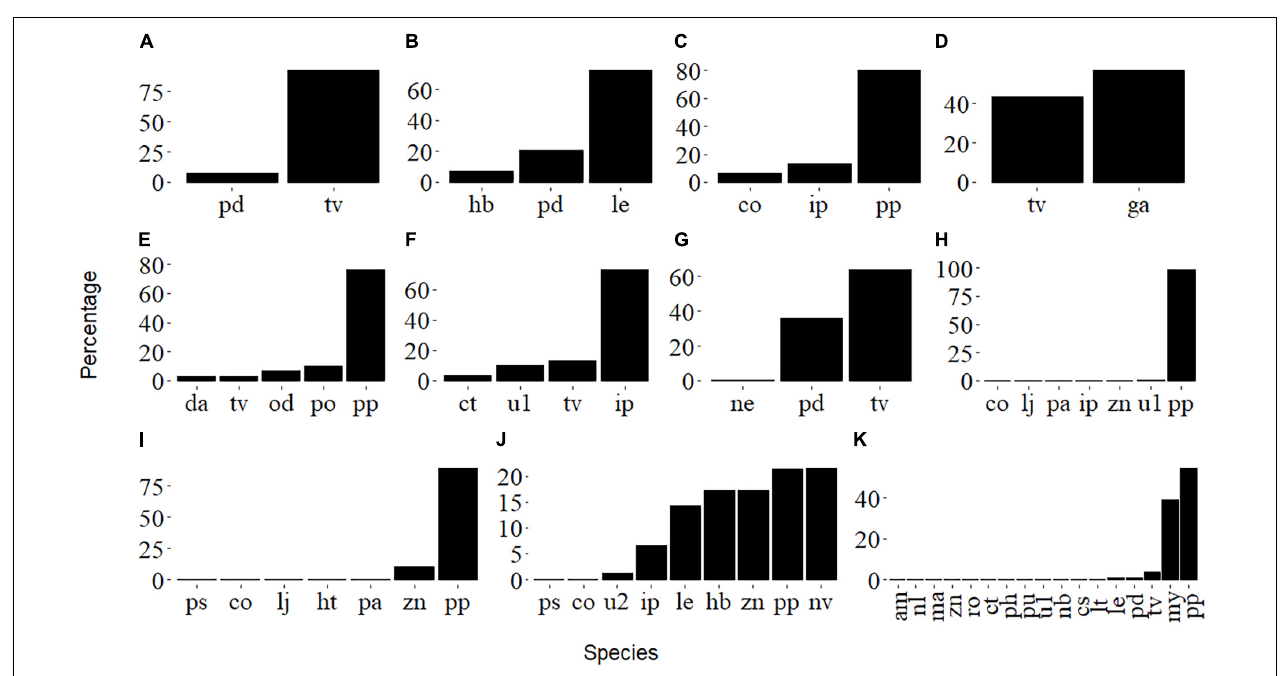
FIGURE 3 | Percentage of prey amplicons for post-larval (i.e., (A–C,G,H )) and juvenile (i.e., (D–F,I–K) ) L . polyactis . See Table 2 for the species abbreviations.